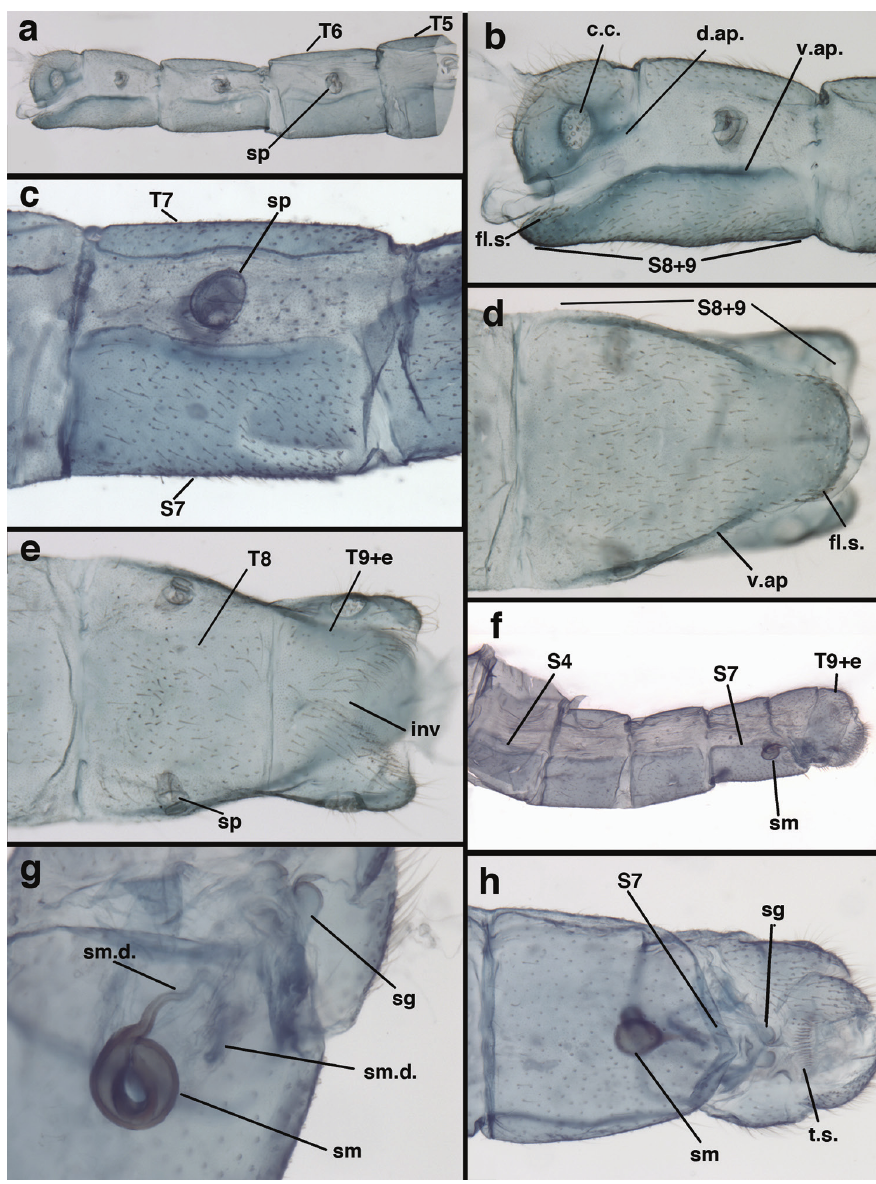
Figure 132. Ungla elbergi Tauber, sp. n. Abdomen, ( a-e ) male ( f-h ) female, ( a ) segments A6-terminus, lateral ( b ) terminal segments, lateral ( c ) segment A7 ( d ) fused sternites S8+9 with flanged setae on margins of terminus ( e ) tergites T8 and T9+ectoproct, dorsal ( f ) segments A4-terminus, lateral ( g ) genital structures ( h ) terminus, ventral. c.c. callus cerci d.ap. apodeme on ventral margin of T9+ectoproct fl.s. flanged setae inv invagination of dorsal T9+ectoproct sg subgenitale sm spermatheca sm.d. spermathecal duct sp spira- cle S4, S7 fourth, seventh sternite S8+9 fused eighth and ninth sternites t.s. transverse sclerite T5–T8 fifth to eighth tergites T9+e fused ninth tergite + ectoproct v.ap. apodeme on dorsal margin of S8+9 (Argentina; a, b, d, e Tucumán, holotype, EMEC; c Tucumán, paratype, FSCA; f–h La Rioja, paratype,